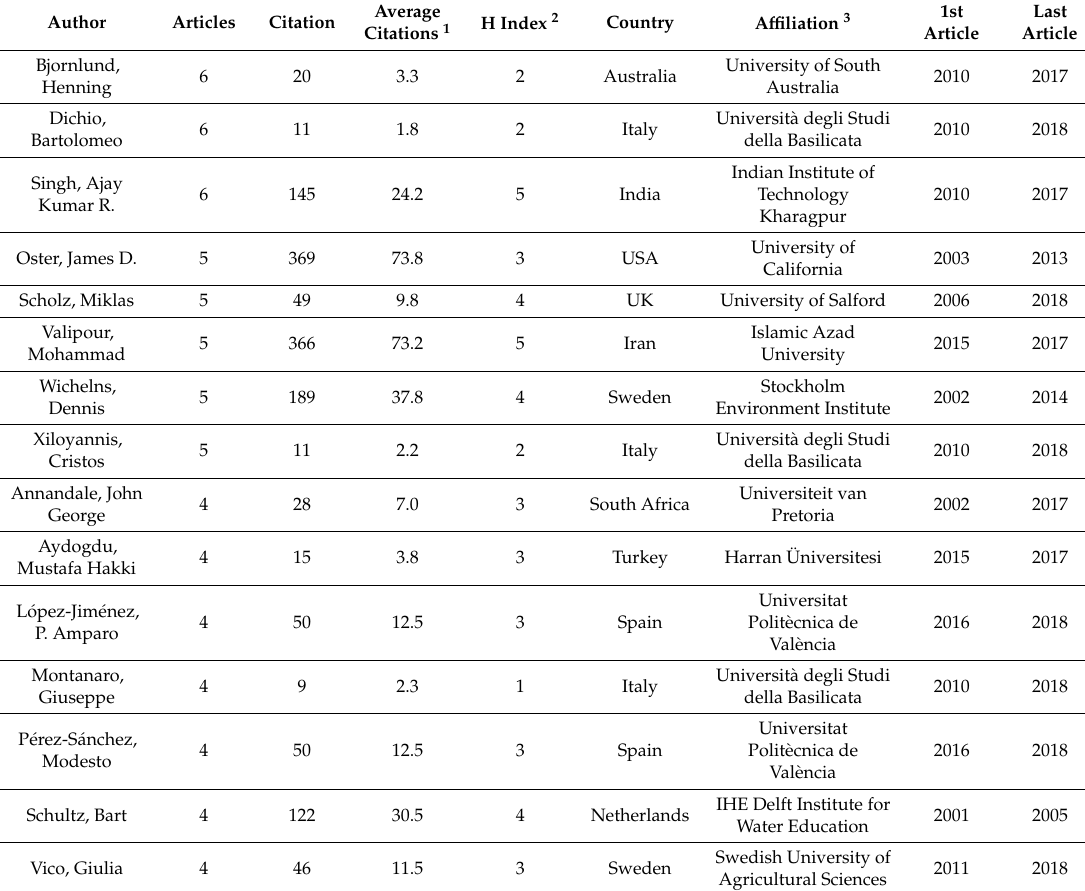
Table 7. Major characteristics of the most active authors related to SI